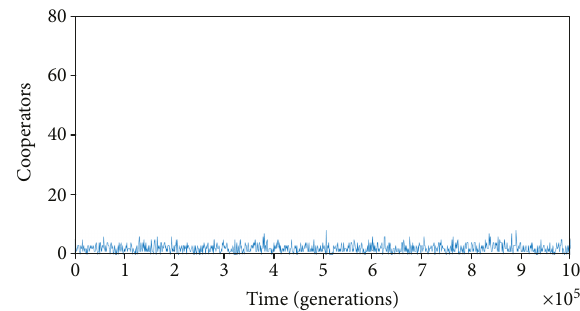
Figure 13: Evolution of the frequency of cooperators in a 50 × 50 system of defectors, where cooperation arises by instantly expressed mutations of gene Y = C